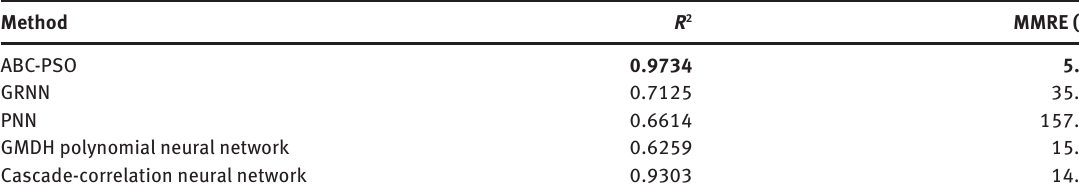
Table 8: Comparison Results Using ABC-PSO with Different Kinds of Artificial Neural Networks.